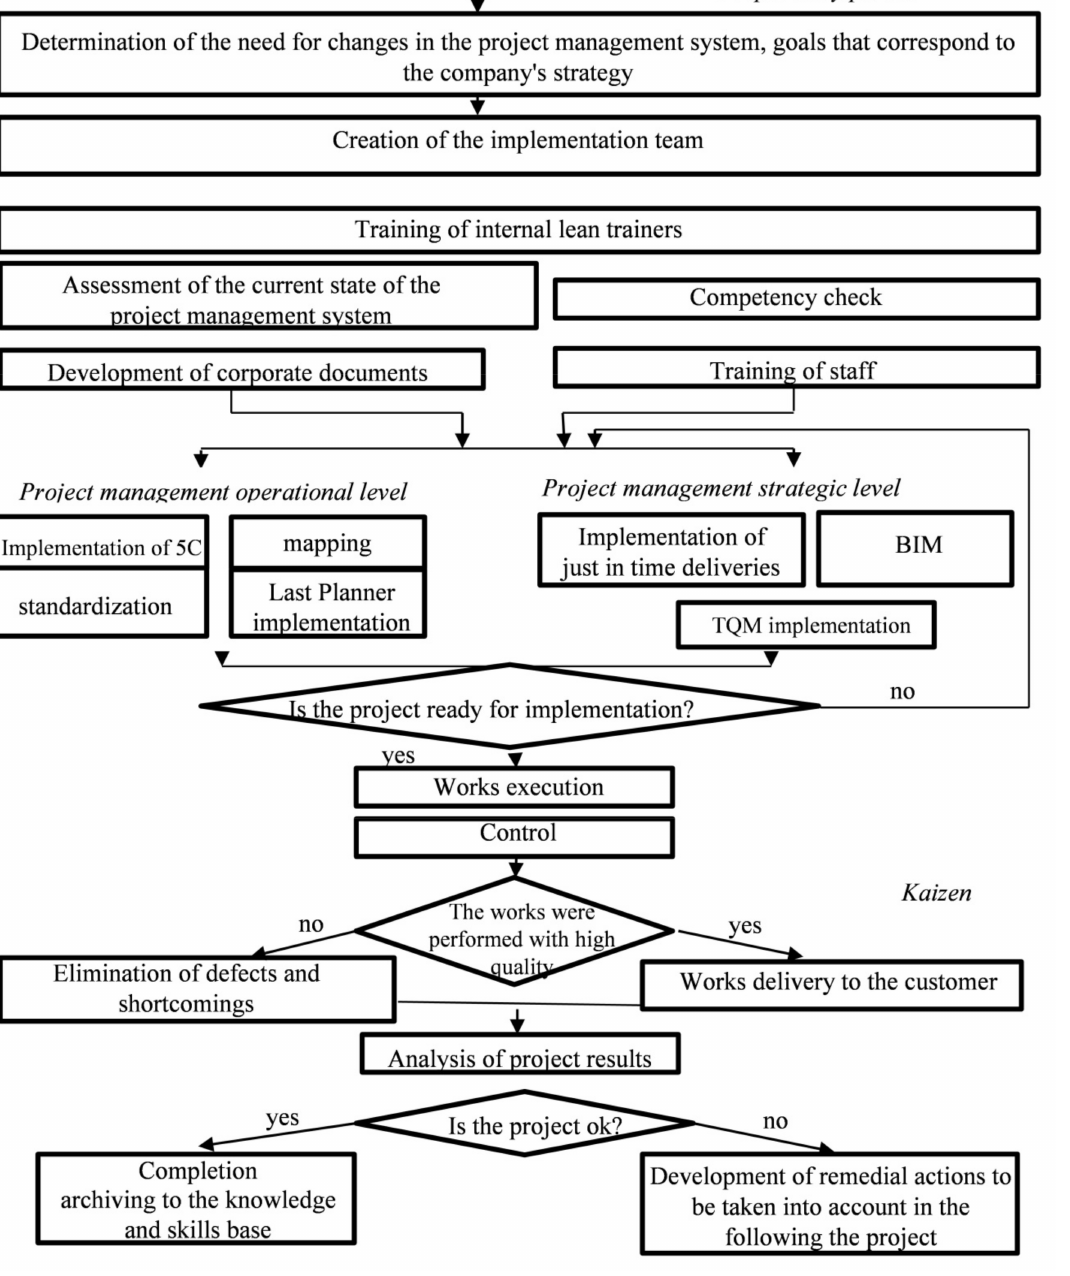
Figure 3. Lean construction project management